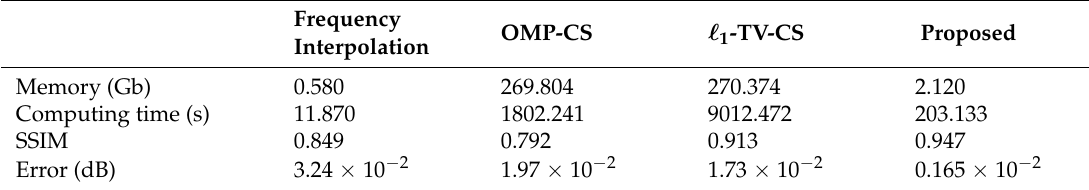
Table 2. Imaging performance